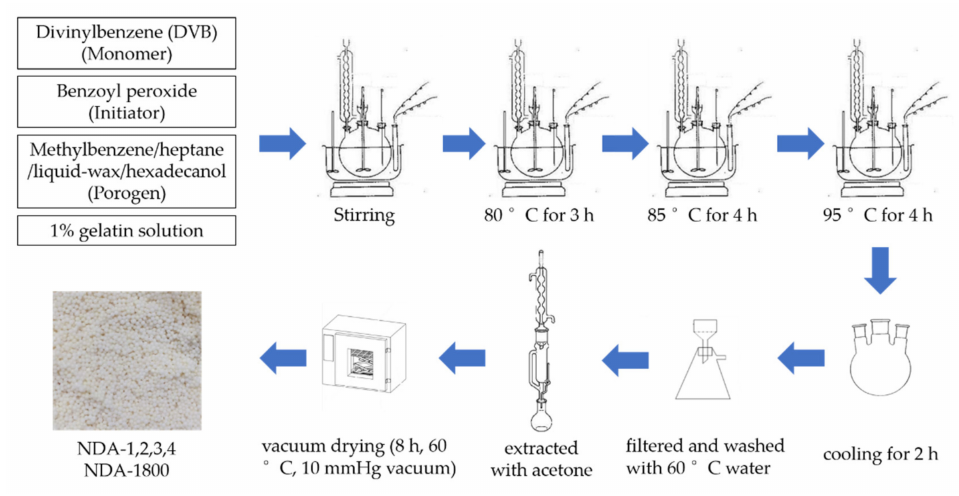
Figure 1. The flow diagram of resin